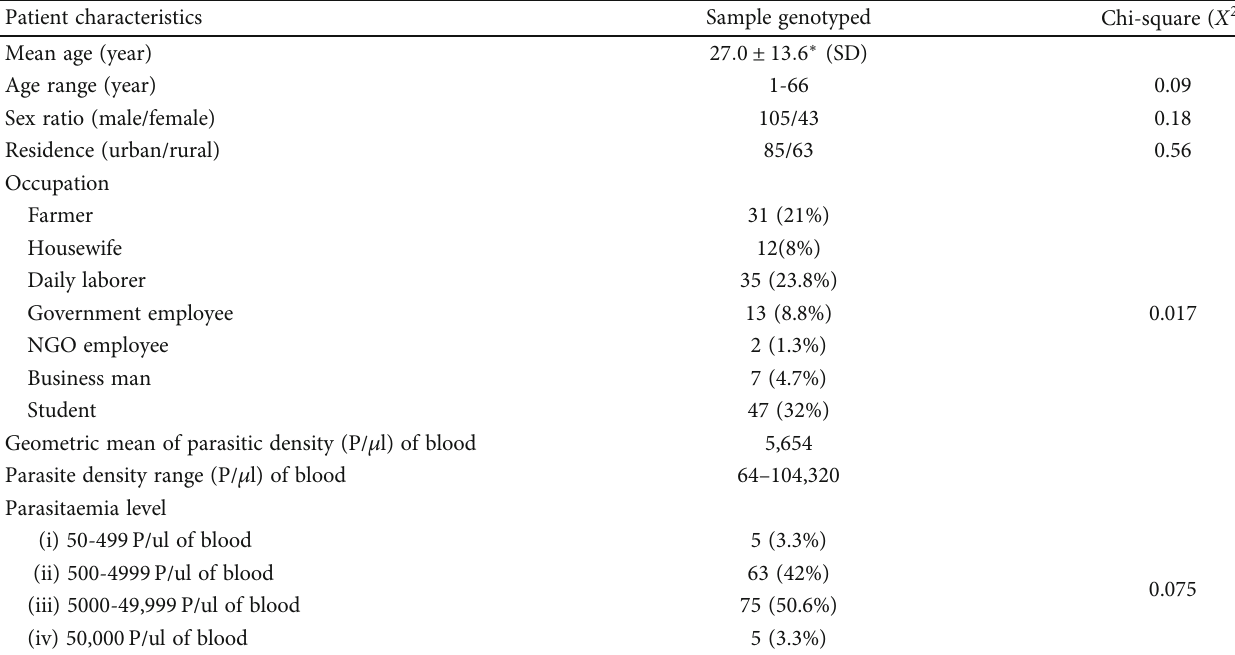
Table 1: Sociodemographic characteristics and parasitological data of symptomatic malaria patients due to P. falciparum clinical isolates genotyped for the msp-2 gene from Adama and its surroundings ( n = 148 ).